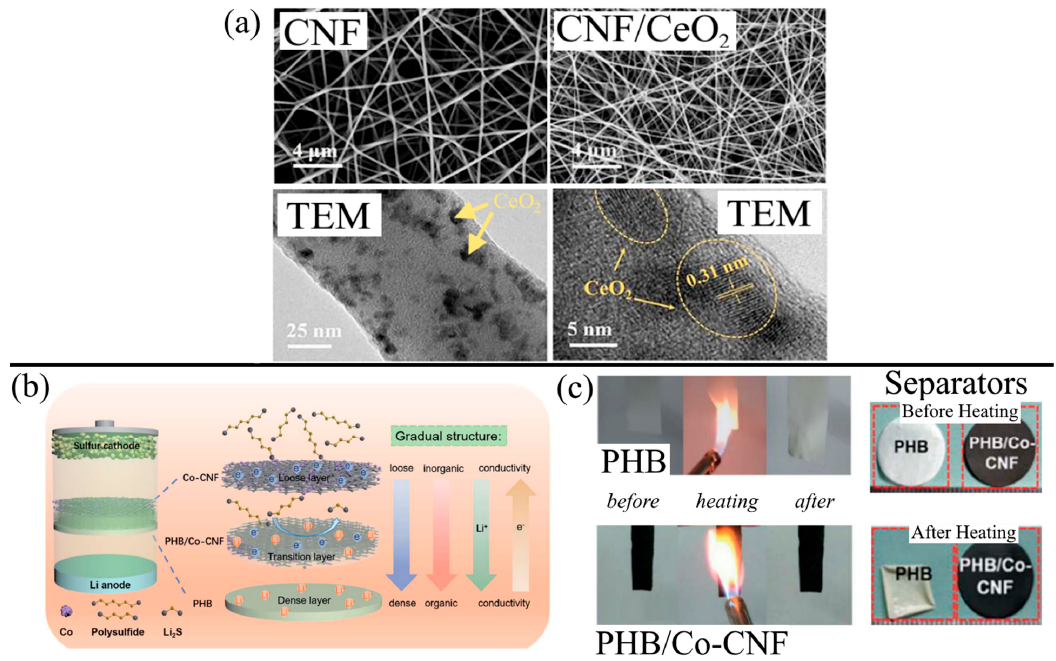
Figure 6. ( a ) SEMs of CNF (Top Left) and CNF/CeO 2 (Top Right) and TEMs at low magnification (Bottom Left) and high magnification (Bottom Right). Reprinted/adapted with permission from Ref. [45]. (Copyright 2020, Elsevier). ( b ) Schematic showing the gradual changes from the loose Co-CNF layer to the dense PHB layer and the consequences of the bilayer structure. ( c ) The flame retarding ability of PHB and PHB/Co-CNF (Left) and thermal stability at 160 °C for the PHB and PHB/Co-CNF separators. Reprinted/adapted with permission from Ref. [109]. (Copyright 2022, Royal Society of Chemistry).